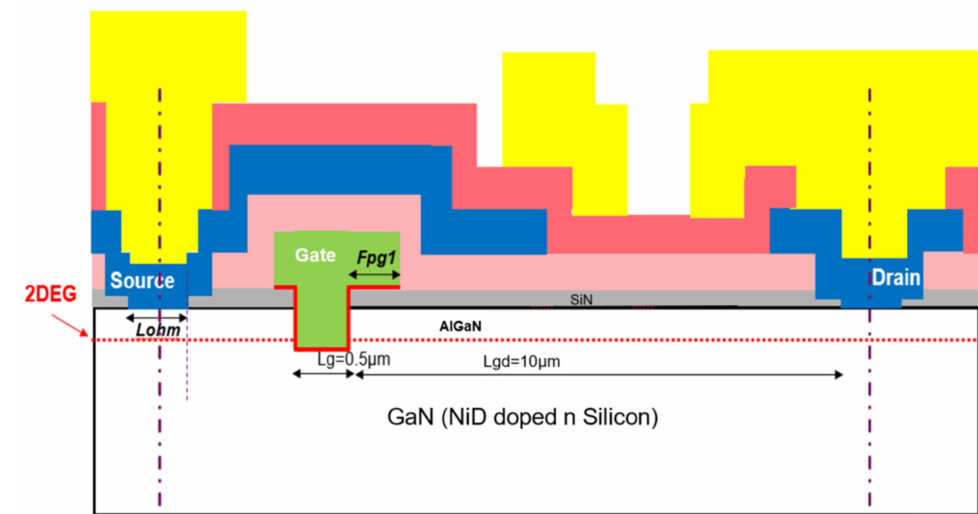
Figure 1. Cross-section of device